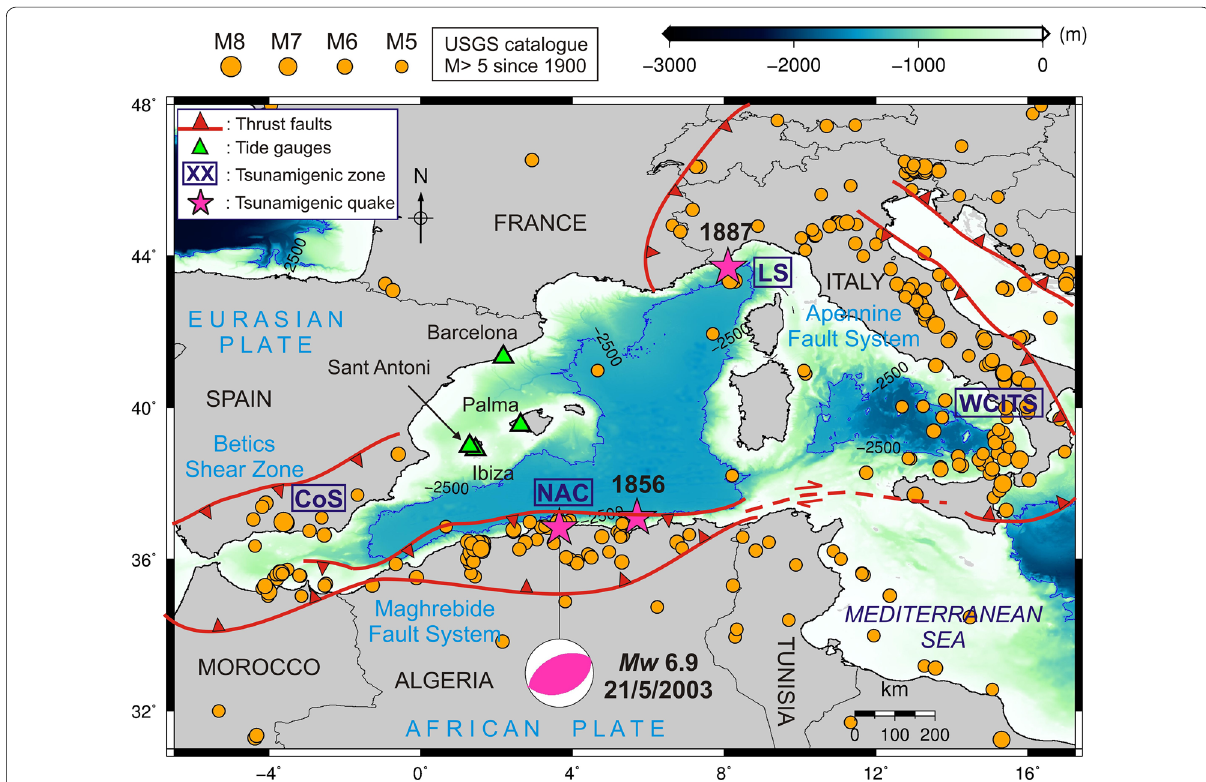
Fig. 1 The Western Mediterranean Basin (WMB) showing the epicenters of tsunamigenic earthquakes in May 2003 (offshore Algeria), 1887 and 1856 (their epicenters are shown by stars). Green triangles indicate locations of tide gauges. Four main tsunamigenic zones in the WMB (blue boxes) are shown based on the data from Soloviev